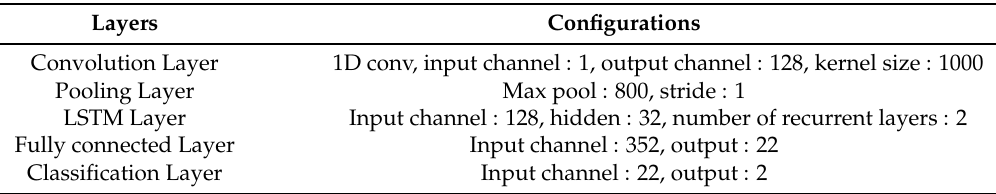
Table 2. An overview of CNN and LSTM architecture